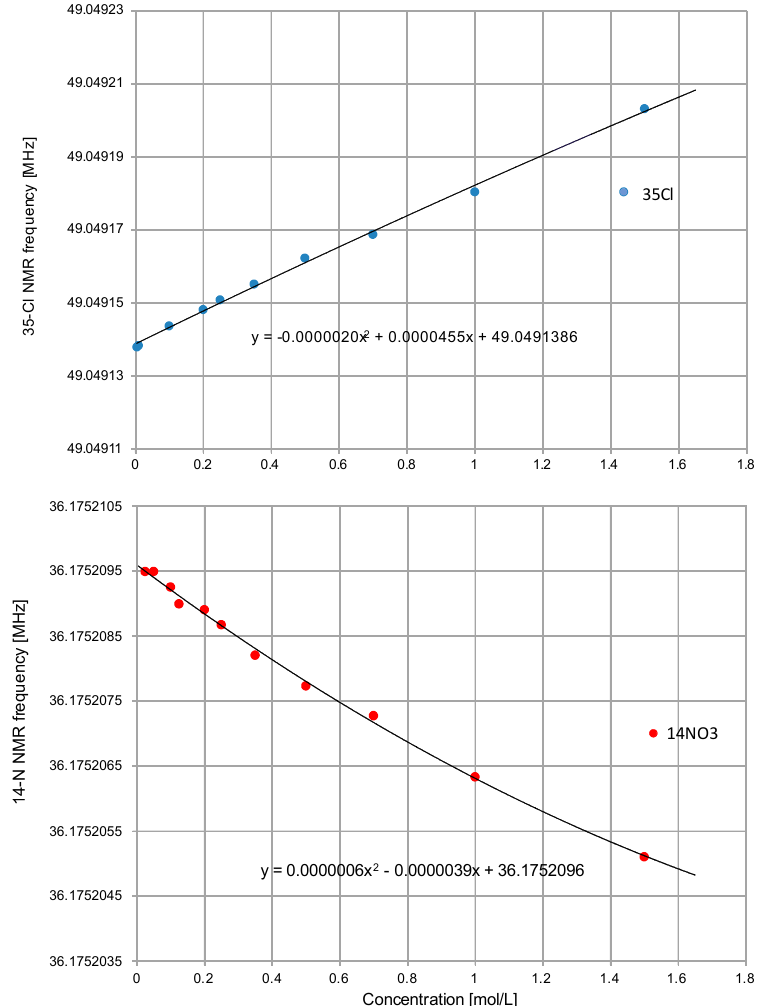
Figure 3. The 14 N and 35 Cl NMR frequencies of Cl − and NO 3 − anions as function of LiCl and LiNO 3 concentration in water solutions. Intersection of the axis represents frequency value at infinite dilution.